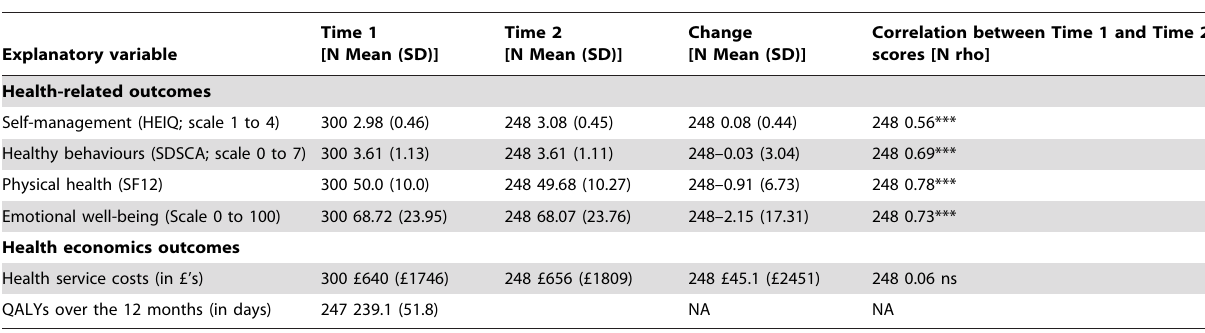
Table 2. Summary statistics for outcome measures.